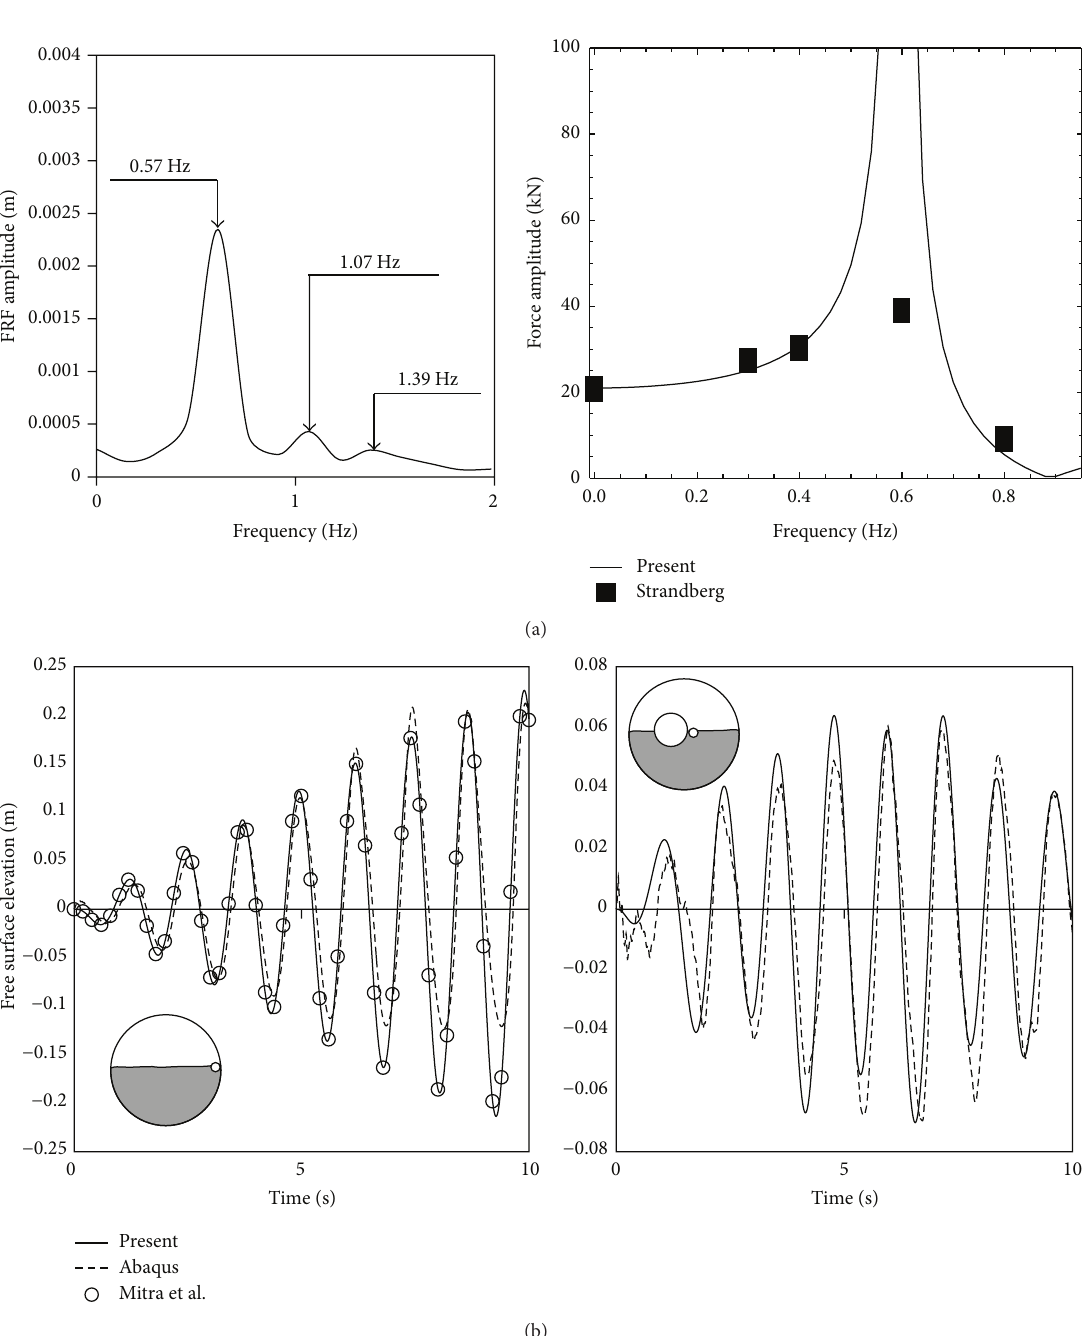
pressure in a circular half full oil tank without inner tube ( 𝜌 = 920 kg/m 2 , 𝑟 1 /𝑟 2 = 0.01 , and 𝑟 2 = 0.95 ) under harmonic acceleration excitation. For this purpose, by derivation of (15) with respect to time and replacing 𝑃(𝑡) = 𝑃(𝜔) sin 𝜔𝑡 and 𝜔𝑡 with 𝐴 = 2.1 ( m / s 2 ) , the maximum 𝐴(𝑡) = 𝐴 0 sin 0